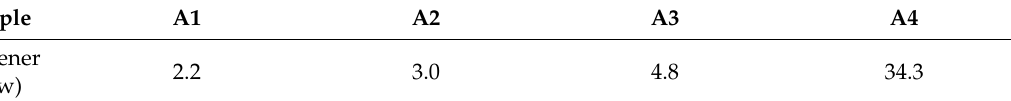
Table 6. Sample appearance of boards made from ammonia-treated oak.